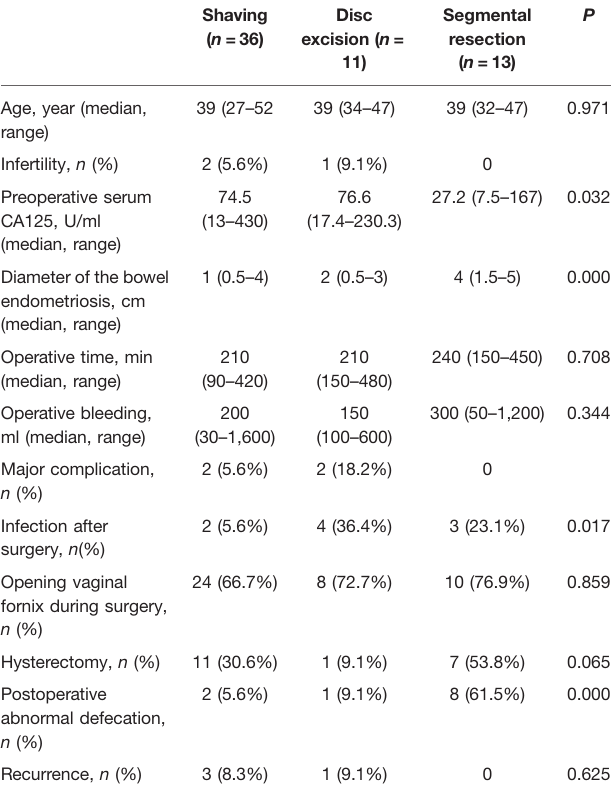
TABLE 1 | Comparisons of clinical characteristics strati fi ed by the type of colorectal surgery.